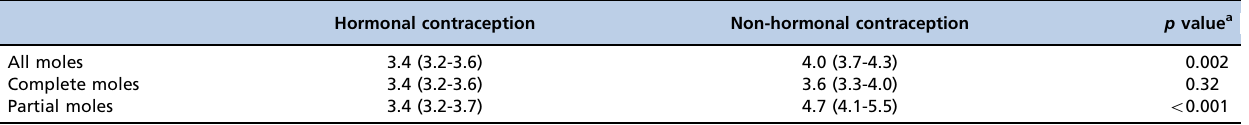
Table S8 - Comparison of hCG half-lives (in days) by contraception type among women with hydatidiform molar pregnancies, adjusted for age with 95% Confidence